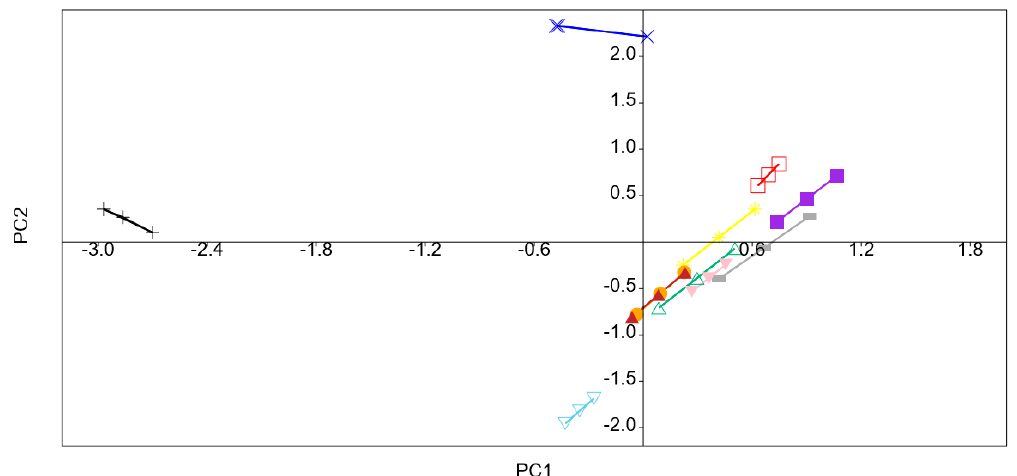
Figure 5. Principal component analysis (PCA) plot of the volatiles of kiwifruit pulp beverage at different treatment conditions. Untreated (+); HT (85 °C for 10 min) ( □ ); 400 MPa/5 min ( ■ ); 400 MPa/10 min ( × ); 400 MPa/15 min ( ※ ); 500 MPa/5 min ( △ ); 500 MPa/10 min ( — ); 500 MPa/15 min ( ▼ ); 600 MPa/5 min ( ● ); 600 MPa/10 min ( ▲ ); 600 MPa/15 min ( ▽ ).